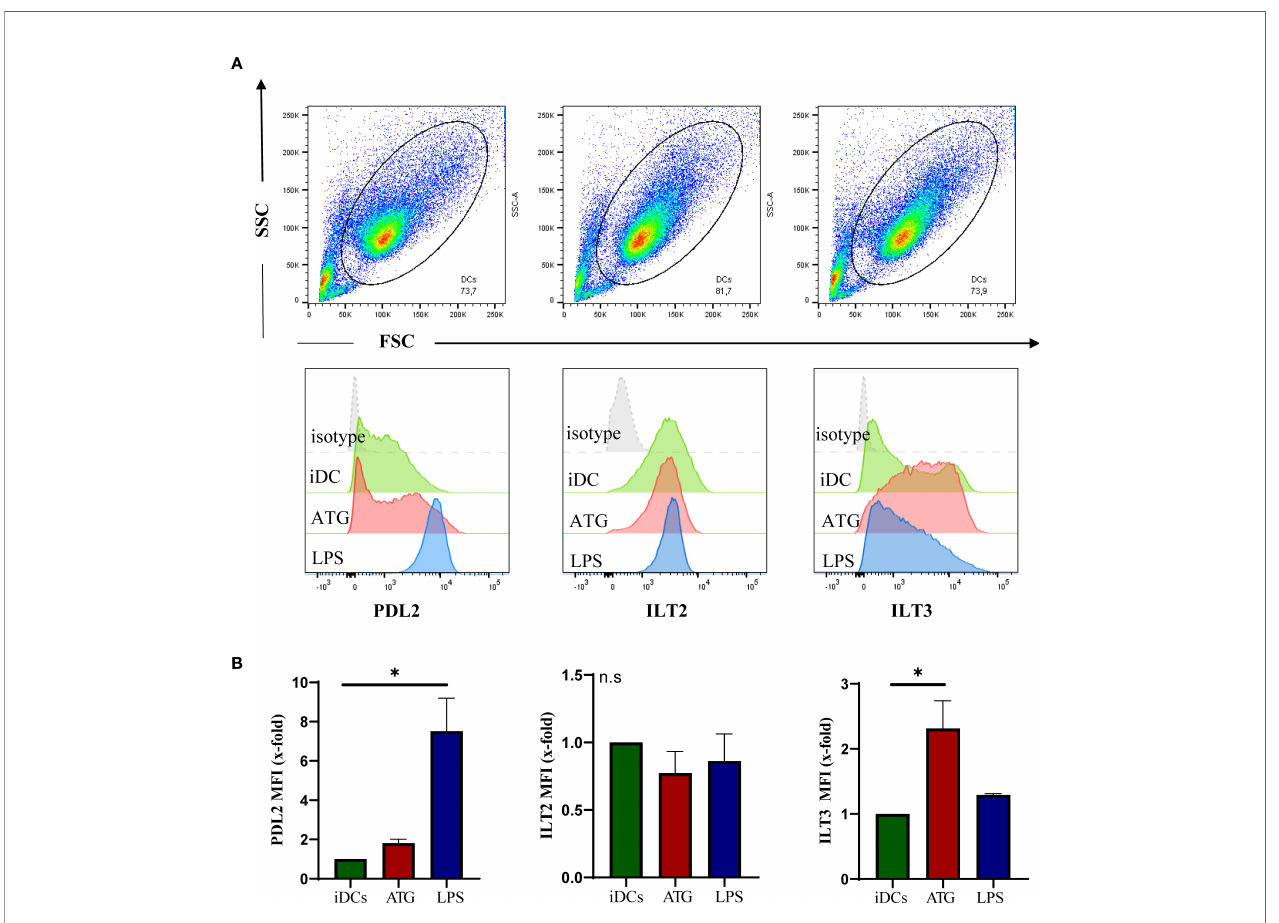
FIGURE 4 | ATG effect on DC phenotype. Human monocyte-derived DCs were stimulated for 48 h with or without ATG (100 µg/ml) or LPS. Afterwards, cells were harvested, washed and stained by means of fl ow cytometry. Shown is a representative dot blot of the respective cell populations and overlaid histograms of the isotype (grey) (A) . Median fl uorescence intensities are summarized in (B) . Data are means ± SEM (n = 3). Statistical analysis was performed using Kruskal-Wallis posthoc test (*p ≤ 0.05, tested versus immature DC (control); n.s. not signi fi